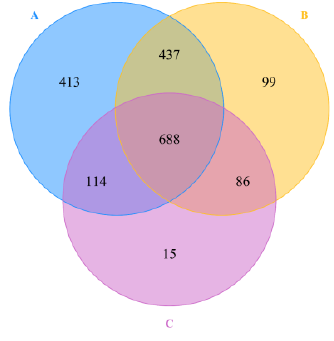
Figure 2. Venn diagram of OTUs between the habitat soil microbiome ( A ) and fecal microbiome of Eurasian otters ( B ) and golden snub-nosed monkeys ( C